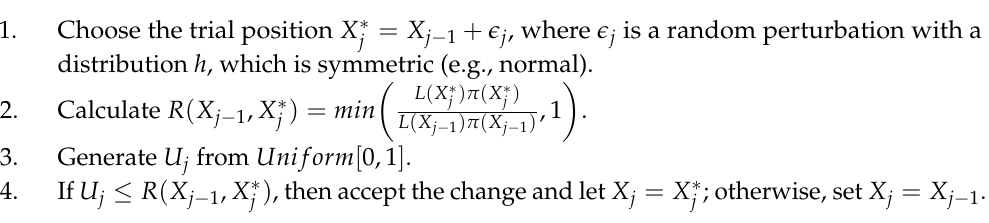
Algorithm 1 The random walk Metropolis–Hastings